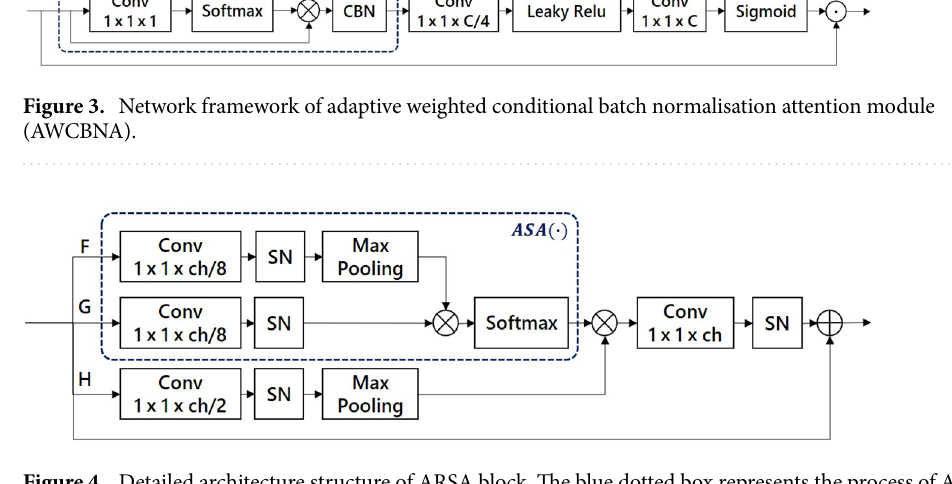
Figure 4. Detailed architecture structure of ARSA block. The blue dotted box represents the process of ASA (